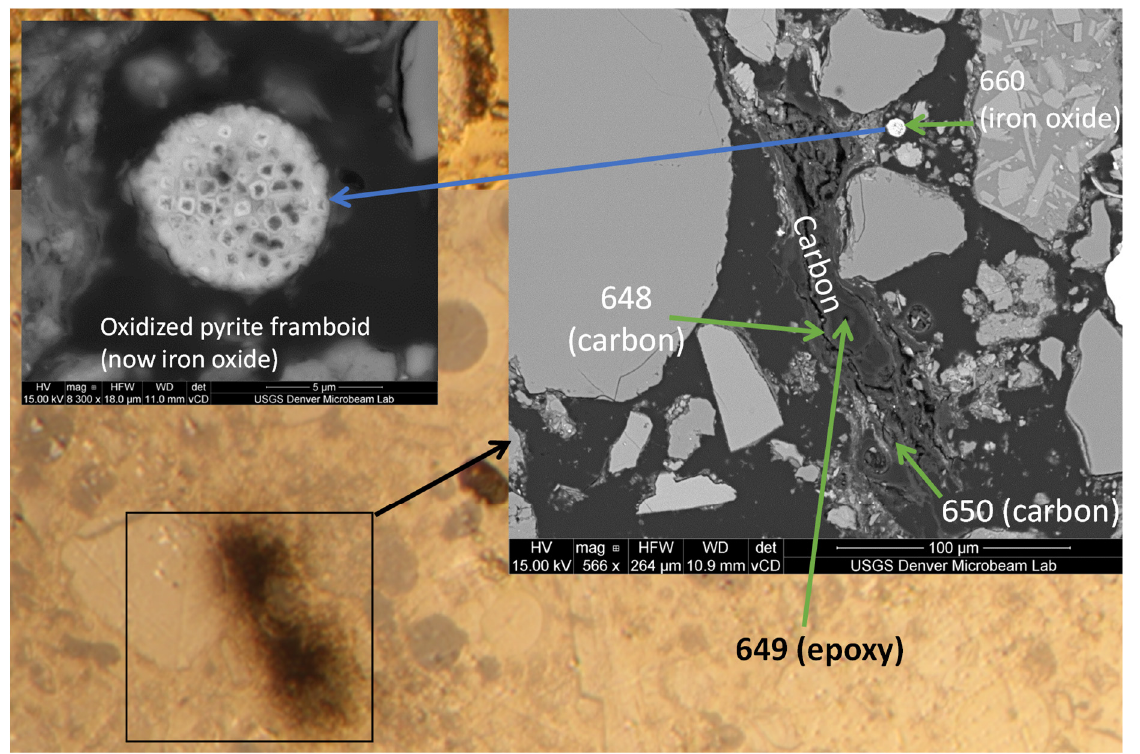
Figure 12. GJAST-14-8 area 9 (Figure 8), thin section plain light background with fission-track overlay at 25% transparency with added SEM-BSE images. Numbering corresponds to spectrums in Figure 13.